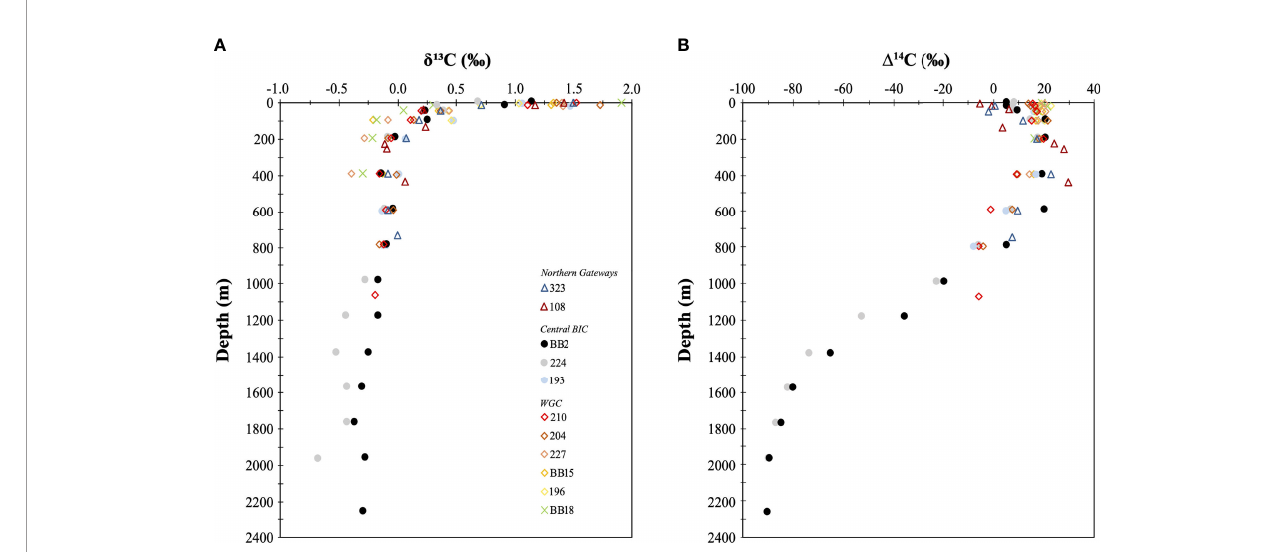
FIGURE 2 | Depth pro fi les of DIC d 13 C and D 14 C values in Baf fi n Bay. (A) measured DIC d 13 C values, ± 0.1 ‰ (See Stable Isotope ( d 13 C) Analysis ). Different sampled stations ( Figure 1 ) indicated by legend, which cover the extent of the Baf fi n Island Current (BIC) in central Baf fi n Bay (circles), the Western Greenland Current (WGC) along the coast of Greenland, (diamonds). and the Northern gateways of Nares Strait and Lancaster Sound (triangles). (B) DIC D 14 C signatures, with errors ranging between ±1.2 to 2.0 ‰ (See “ Natural Abundance Radiocarbon ( D 14 C) Analysis ” and “ Estimation of Anthropogenic (DIC anth ) and “ Bomb ” DIC 14 C ”